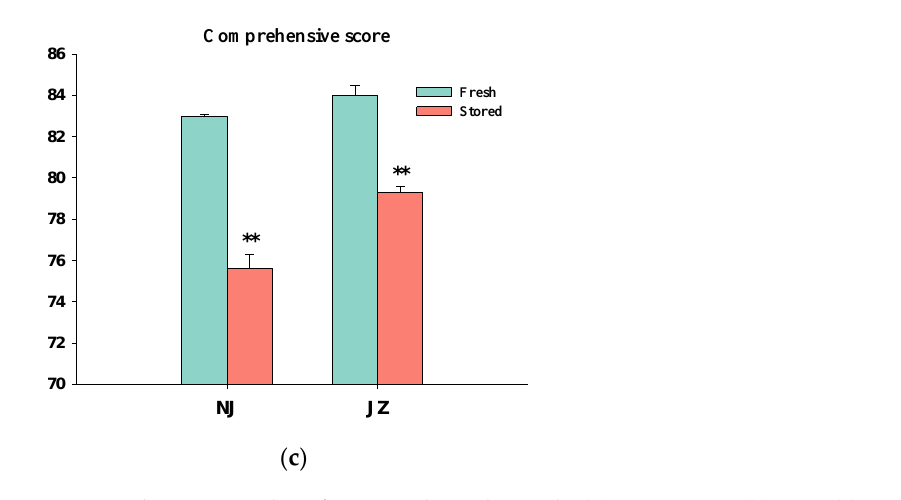
Figure 1. The eating quality of rice samples in this study. ( a ) Appearance; ( b ) Taste; ( c ) Comprehensive score. ( n = 3, *: means the stored group is significantly different compared with the fresh group in the same variety when α = 0.05; **: means the stored group is significantly different compared with the fresh group in the same variety when α = 0.01). Table 1. Texture characteristics and pasting properties of NJ and JZ ( n = 3, α =